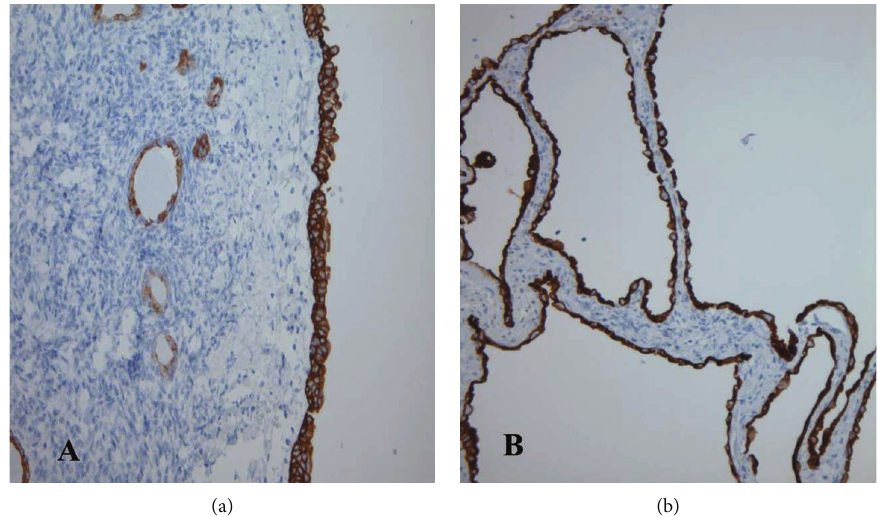
Figure 3: Immunohistochemical staining. (a) The cyst lining epithelium showing positivity for HMWCK (100x). (b) Positivity for CK7 in the cyst lining epithelium